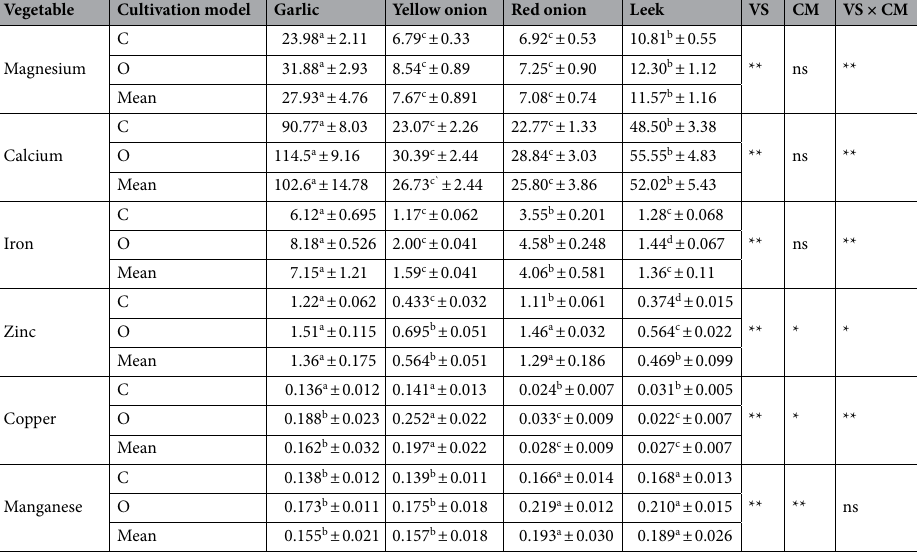
Table 4. Content of minerals (mg 100 g −1 DW) in Allium vegetables depending on the cultivation model (conventional—C; organic—O). VS vegetable species, CM cultivation model (conventional vs. organic). *Correlation significant at p ≤ 0.05 (one-way analysis). **Correlation significant at p ≤ 0.01 (one-way analysis). a,b ,c,d Values with different superscript letters in a row are significantly different at p ≤ 0.05.